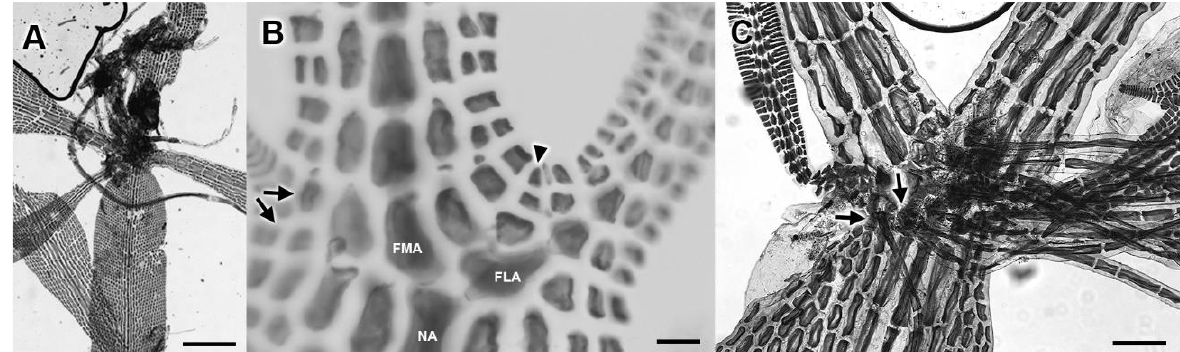
Figure 6. Caloglossa manaticola sp. nov. ( A ) Adventitious branches at node resulting in palmate pattern, scale = 500 µm. ( B ) Cell arrangement at node showing the nodal axial cell (NA) with a single row of cells developing from it towards both margins; the first main axial cell (FMA) with two rows of cells developing from it opposite the lateral axis (arrows), and the first lateral axial cell (FLA) with an adaxial cell row (arrowhead), scale = 20 µm. ( C ) Rhizoids originating from nodal periaxial and marginal wing cells with examples of a single rhizoid developing from a wing cell and two rhizoids developing from a lateral pericentral cell of the nodal axial cell indicated (arrows), scale = 100 µm.